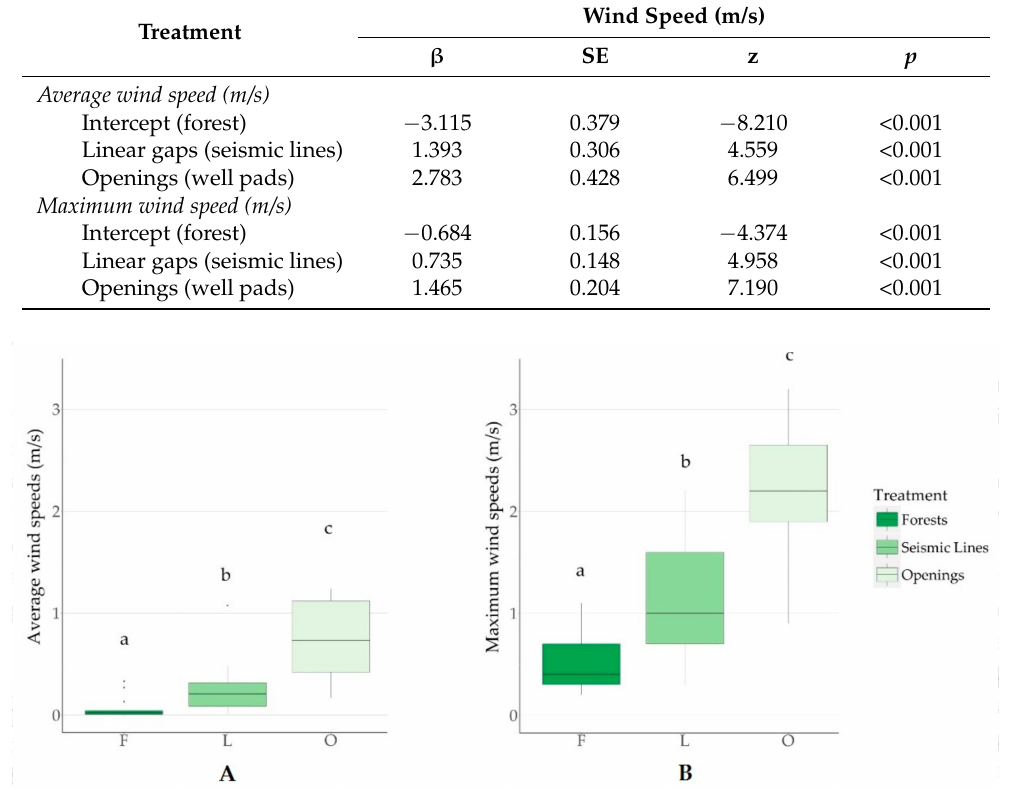
Figure 3. Boxplots of ( A ) average wind speed and ( B ) maximum wind speed in m/s for forests (F), seismic lines (L), and well pad openings (O) across 45 sites in northeast Alberta, Canada. Post hoc Tukey tests were used to assess differences between groups with different letters signifying significant differences ( p <